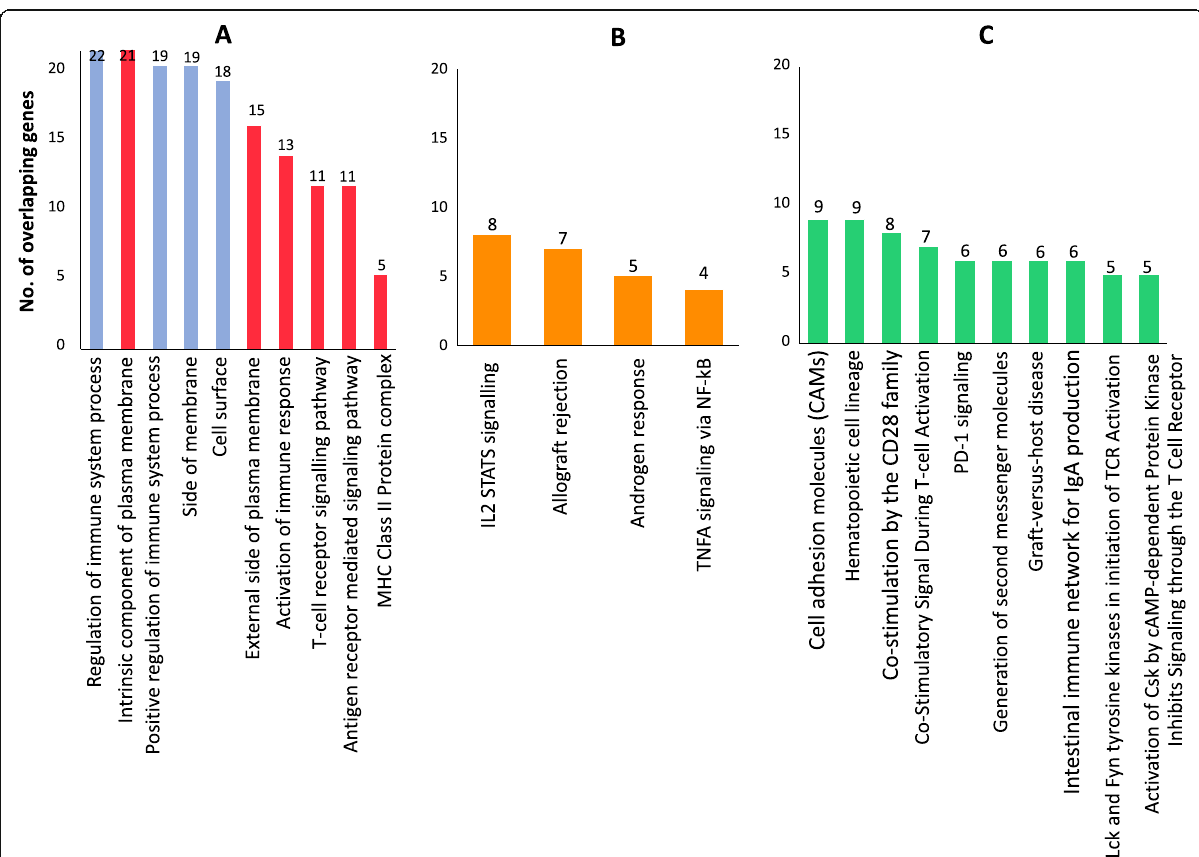
Fig. 1 Analysis of the overlap of the cured genes with the three annotated sets in MsigDB Gene ontology BP and CC (GO), b Hallmark, and c canonical pathways (CP). The y -axis depicts the number of overlapping genes and the x -axis lists the pathway terms. Blue indicates cellular component (CC); red, biological process (BP); orange, Hallmark; and green, canonical pathways